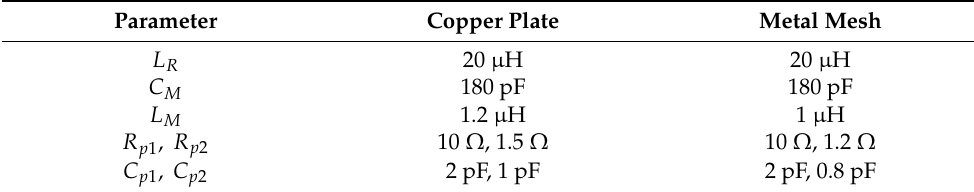
Table 2. Experimental circuit component